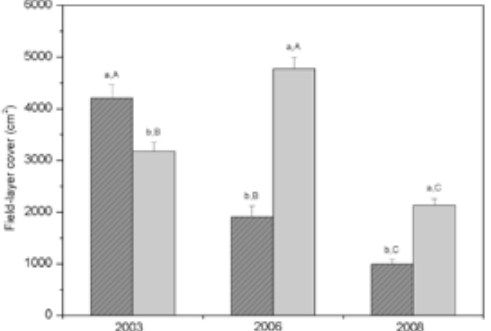
Fig. 4. Changes in mean field-layer cover area (cm 2 ) in the experimental plots in site 1 – clear- cut (striped; n =22) and site 2 (grey; n =26) over time. Different lower case letters in- dicate significant between-treatment differ- ences (Tukey’s test: P <0.05); different capi- tal letters indicate significant between-year differences (Paired t -test: P <0.05). Error significantly, by about 50% between 2003 and 2006, then further declined between 2006 and 2008 to ca. 10% of the total plot area. At site 2